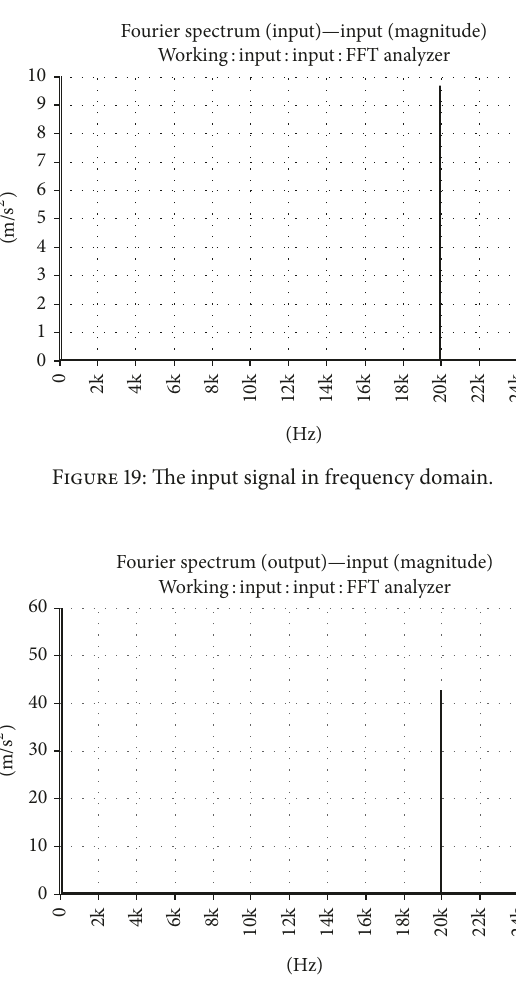
Figure 20: The output signal in frequency